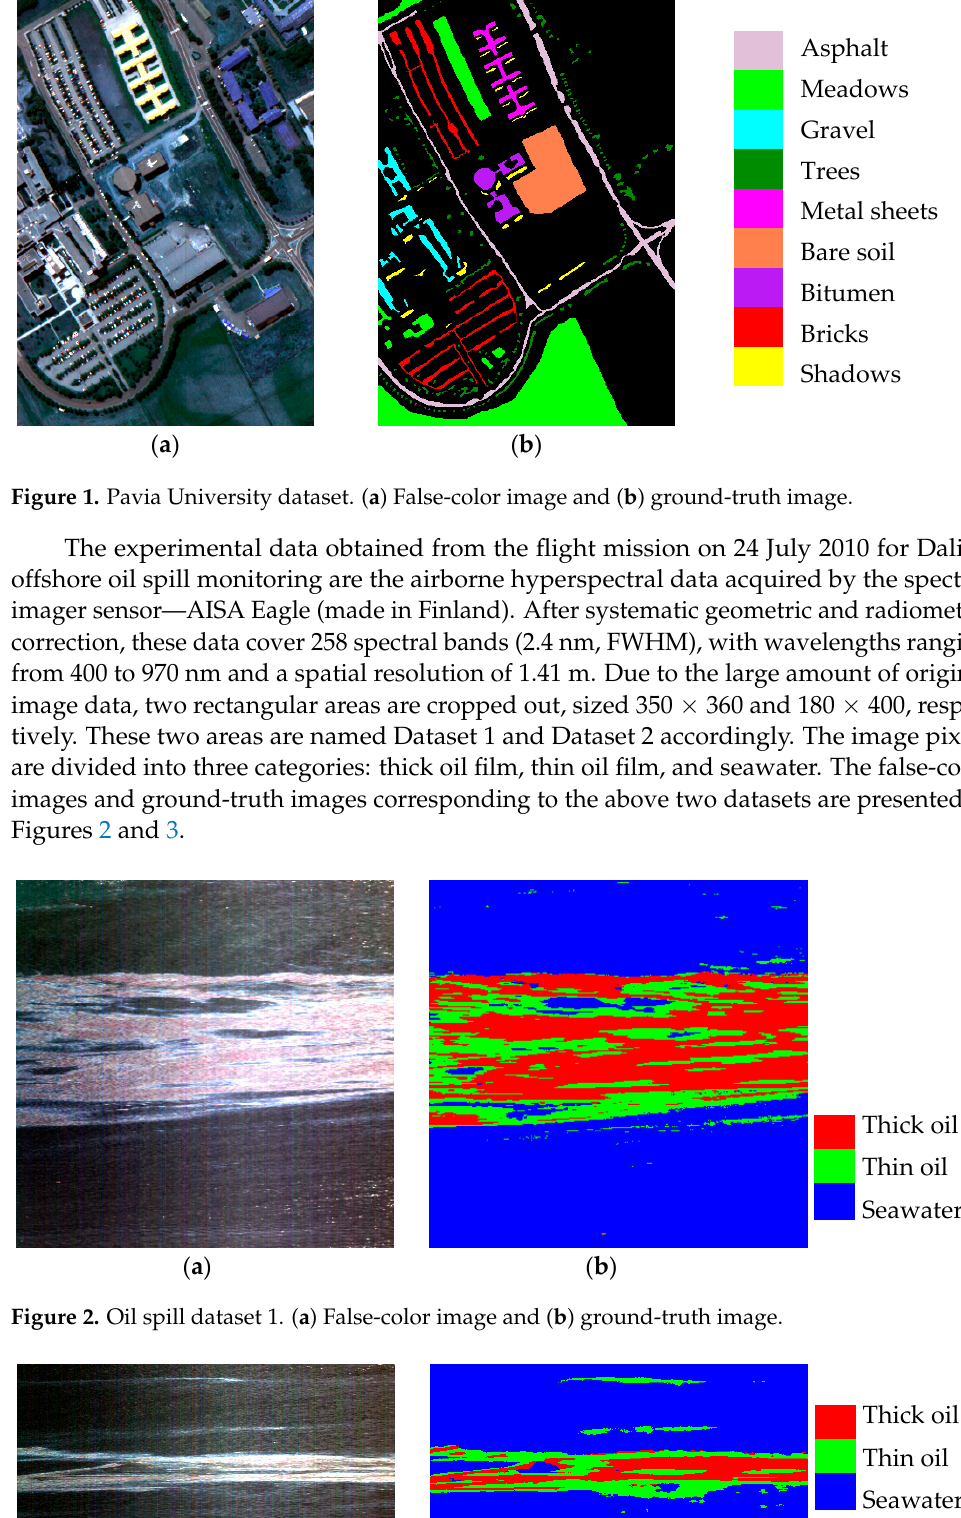
Figure 1. Pavia University dataset. ( a ) False-color image and ( b ) ground-truth image.